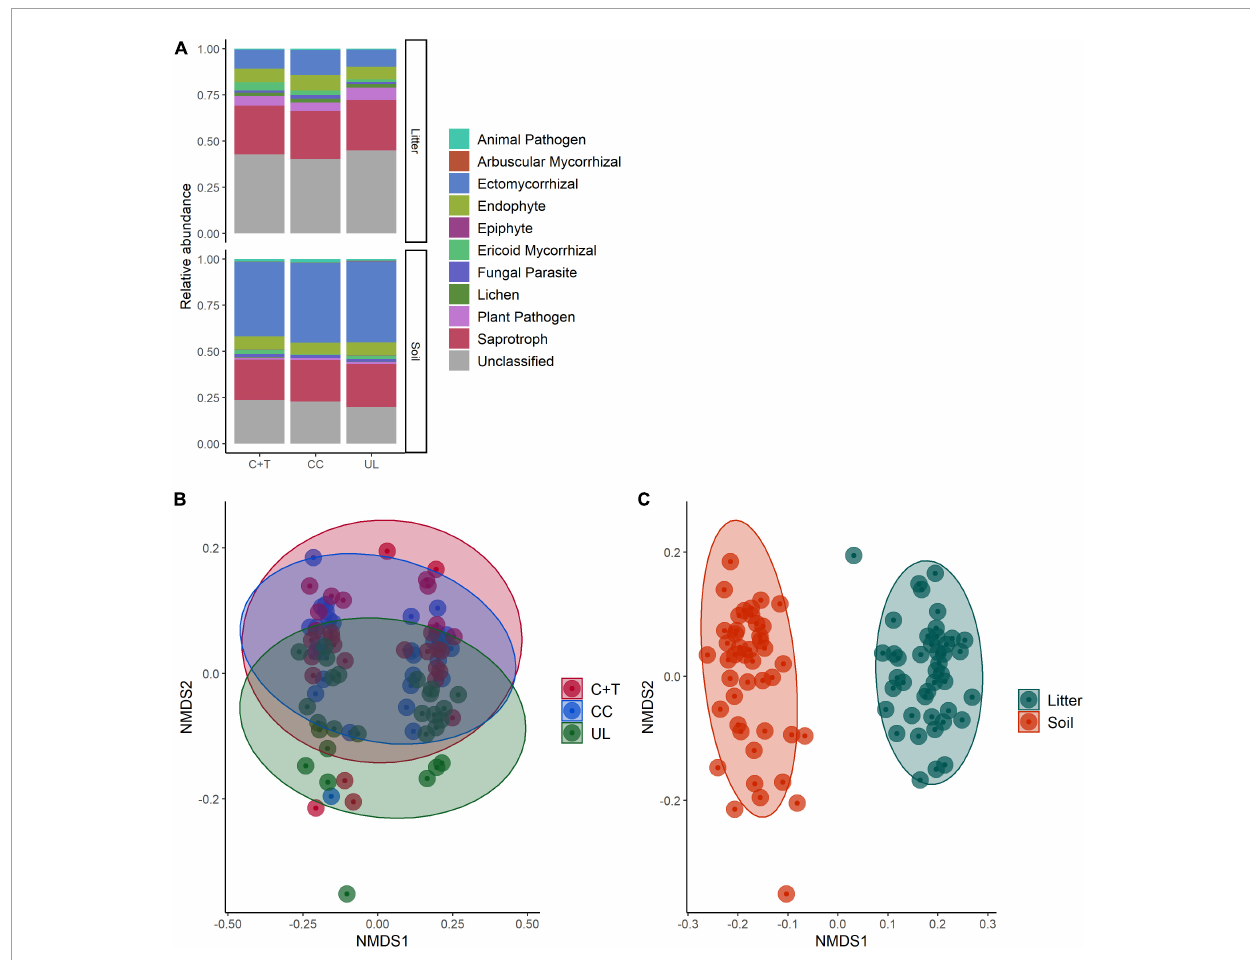
FIGURE6 Comparisons of fungal communities in soil and litter of three watersheds with varying logging histories within the H. J. Andrews Forest, Oregon, USA. Clearcut (CC), watershed 6, canopy + thinned (C + T), watershed 7, unlogged (UL), watershed 8. (A) Relative abundances of functional guilds between watersheds for soil and litter. Functional guilds were assigned using FUNGuild analysis. (B) NMDS ordination of fungal communities based on Bray-Curtis dissimilarities comparing watersheds (PERMANOVA, p < 0.001). (C) NMDS ordination of fungal communities based on Bray-Curtis dissimilarities comparing soil and litter (PERMANOVA, p <